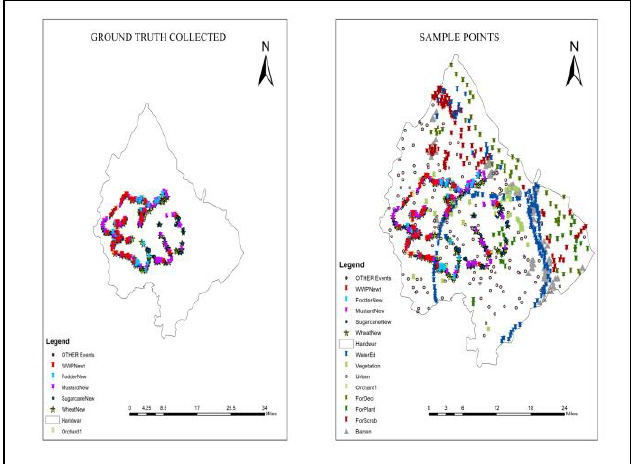
Figure 2. a) Ground Truth Data Collected for Major Crops and Sample Reference points generated for other classes using high resolution